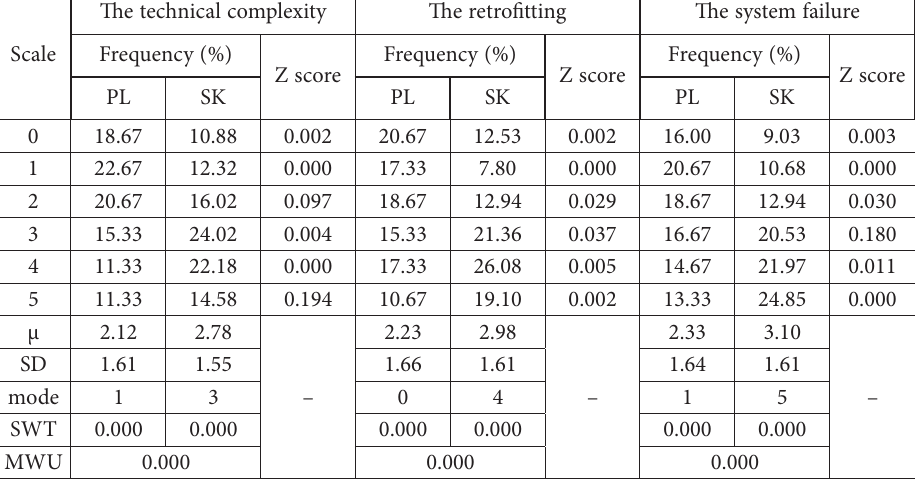
Table 3. The technical complexity, the retrofitting and the system failure of